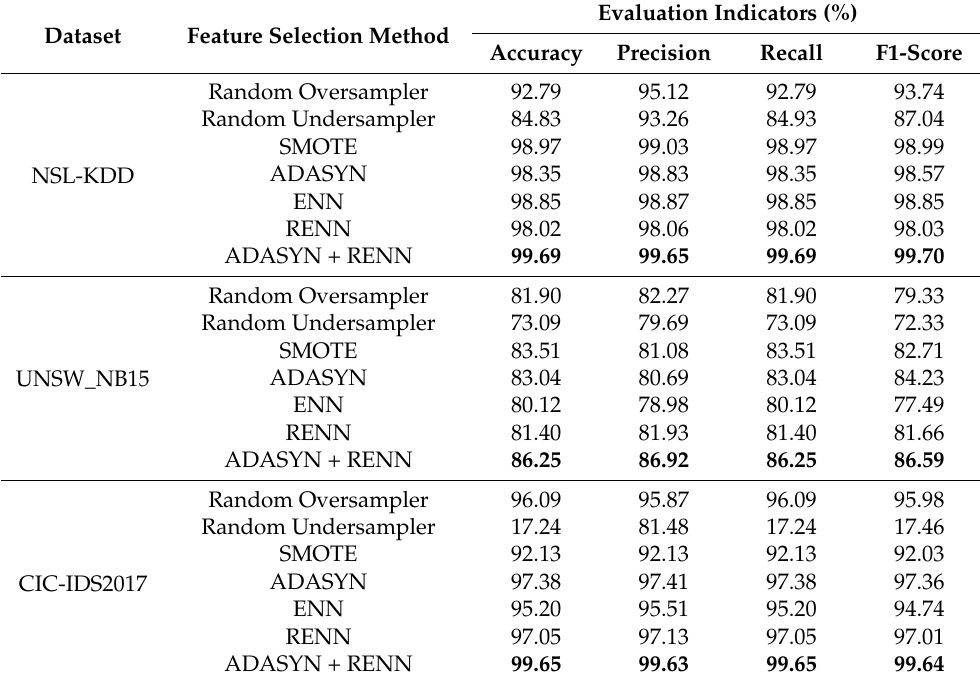
Table 10. Comparison of different sampling